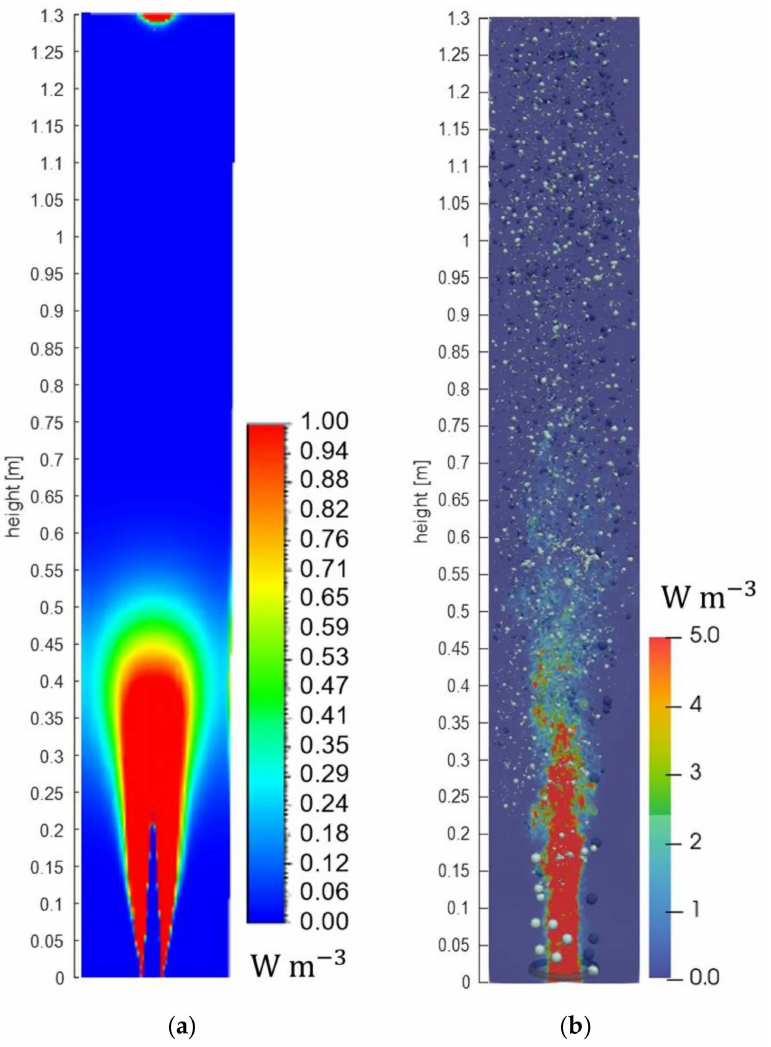
Figure 3. Flow field as contour plot shown as a section plane, where turbulent dissipation rate is depicted. Simulation of bubble column in Ansys Fluent. ( a ): Ansys Fluent simulation ( b ): M-Star